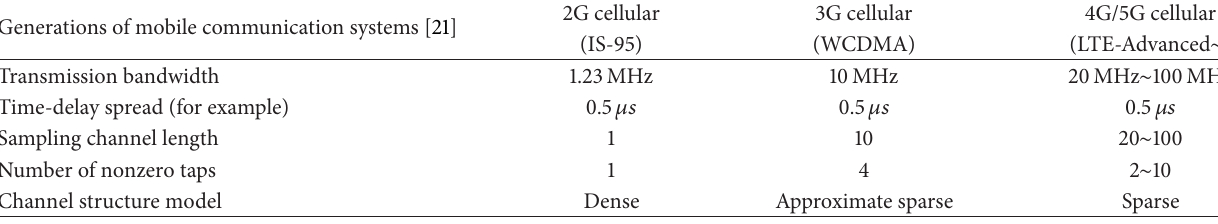
Table 1: Channel structures in different mobile communication systems.